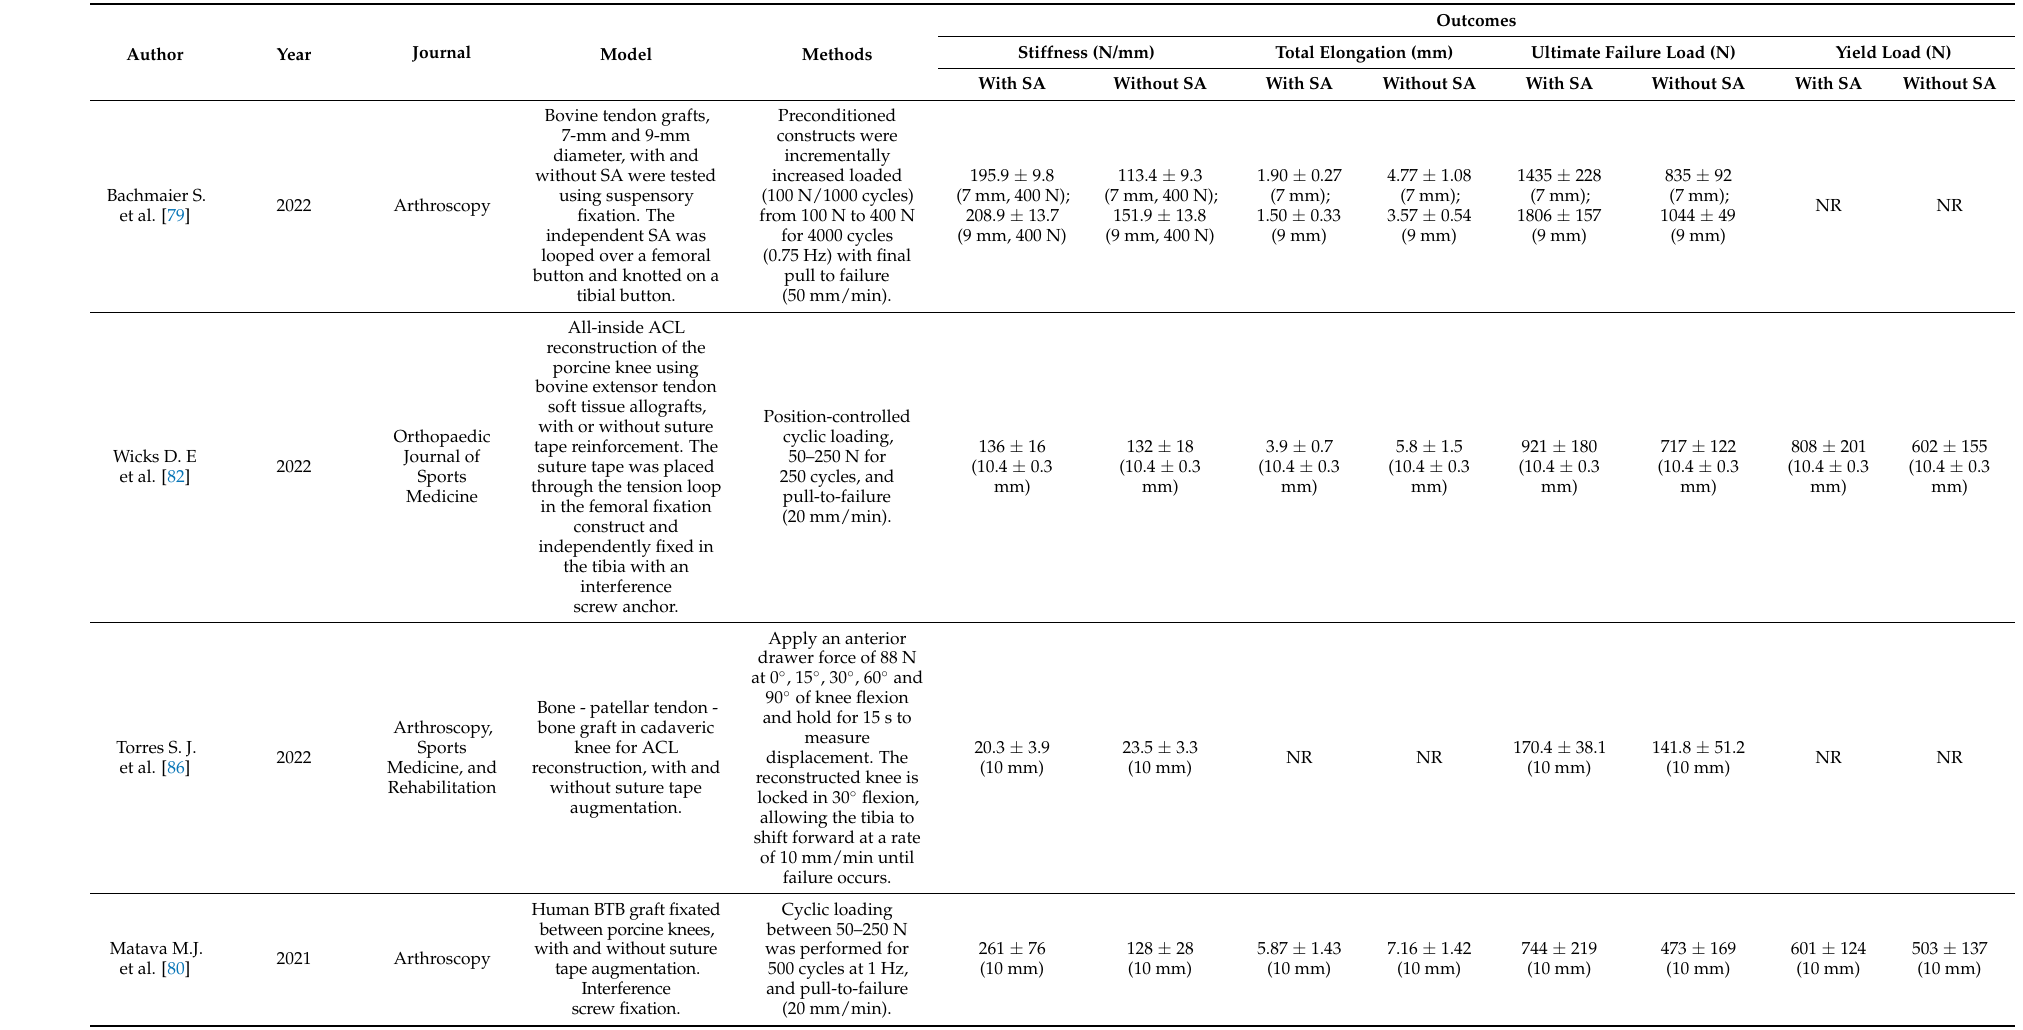
Table 1. Biomechanical Studies of ACL Primary Repair or reconstruction with